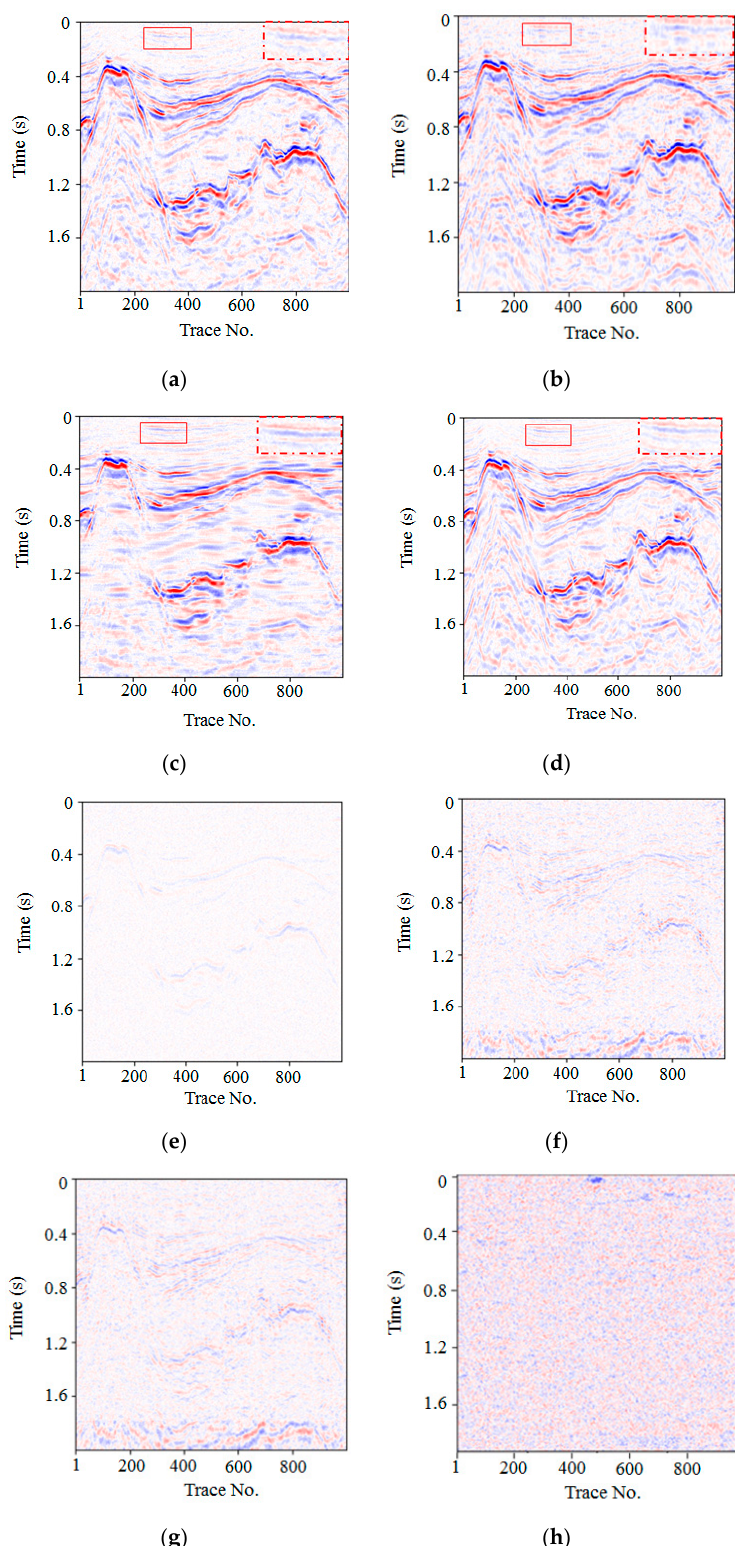
Figure 12. Denoising comparison of real seismic data results. Denoised results obtained